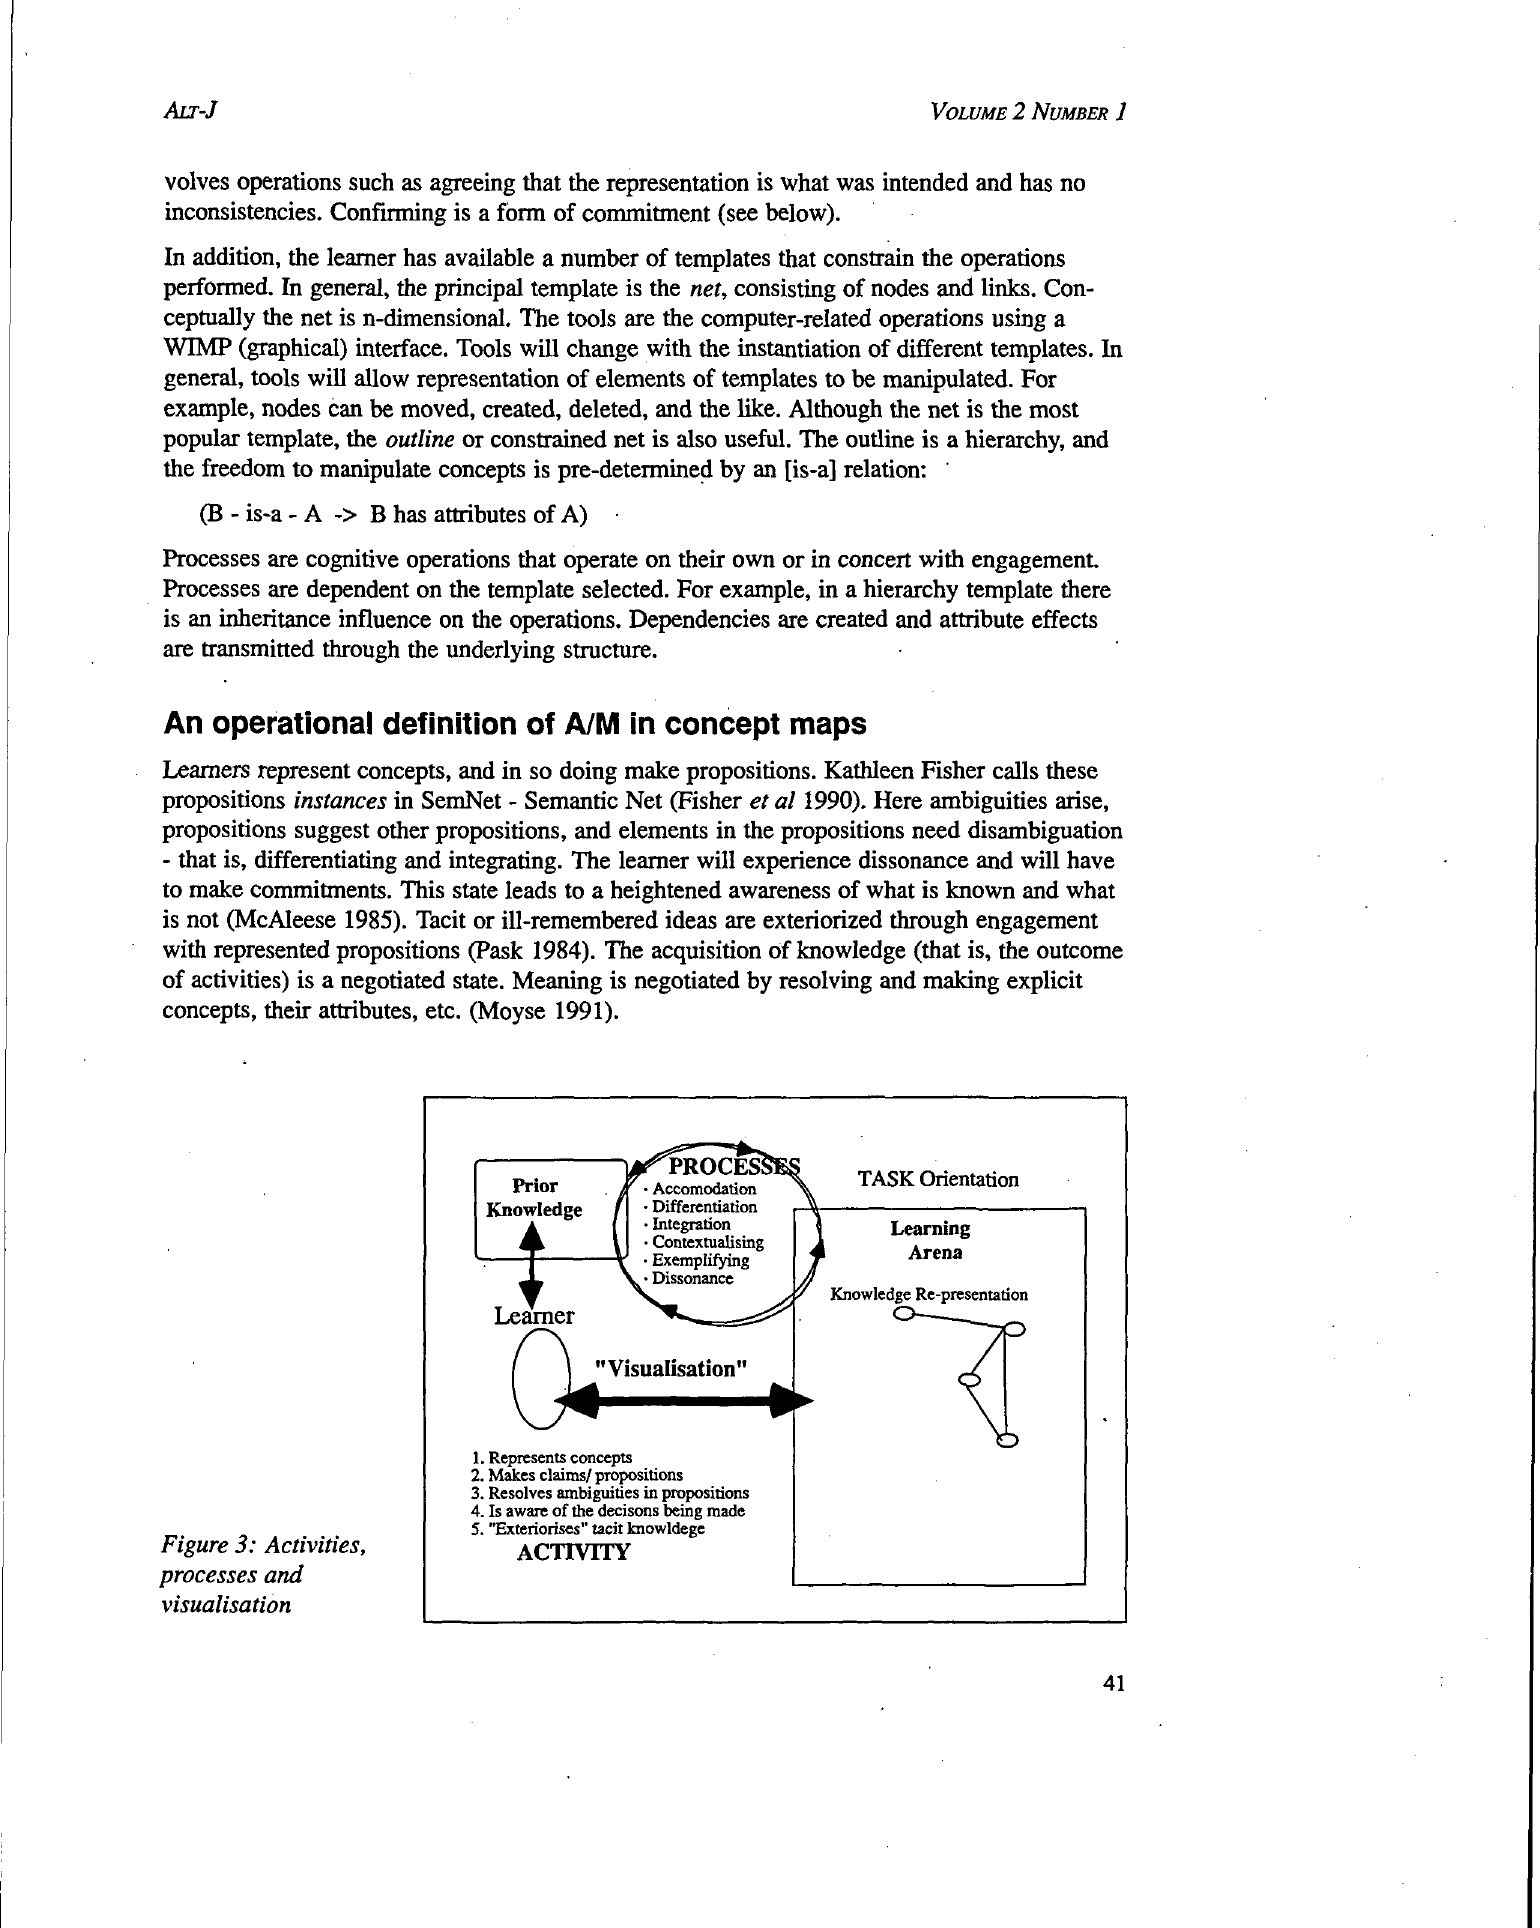
Figure 3: Activities, processes and